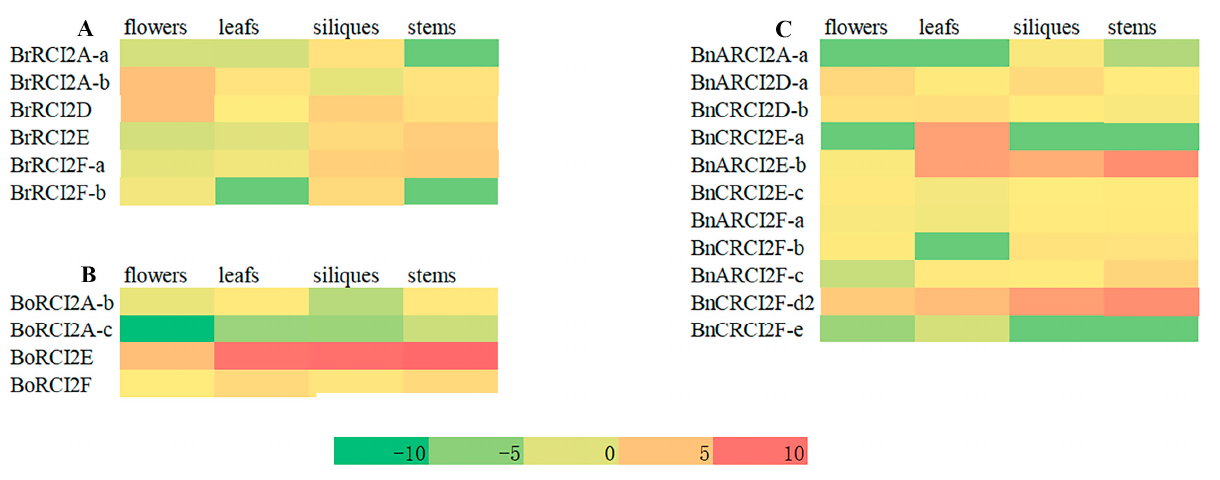
Figure 7. Expression patterns of RCI2 genes in four tissues (stem, leaf, flower, silique) of B. rapa ( A ), B. oleracea ( B ) and B. napus ( C ).